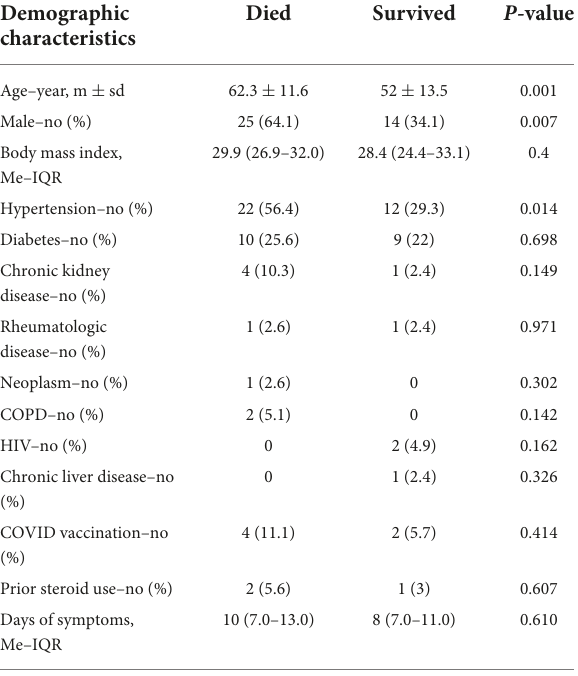
TABLE 1 Demographic characteristics of patients with COVID-19 pneumonia admitted to intensive care units. Demographic